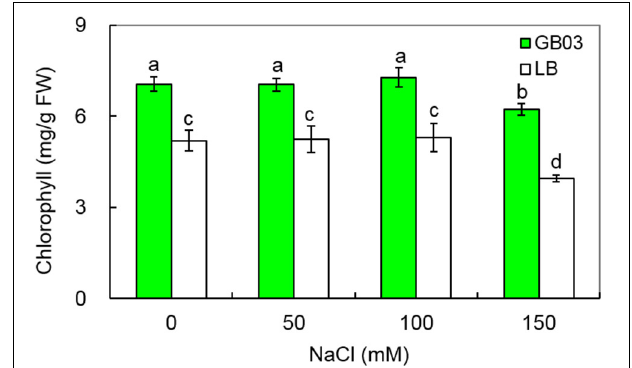
( Lycopersicon esculentum ) (Mayak et al., 2004), chickpea (